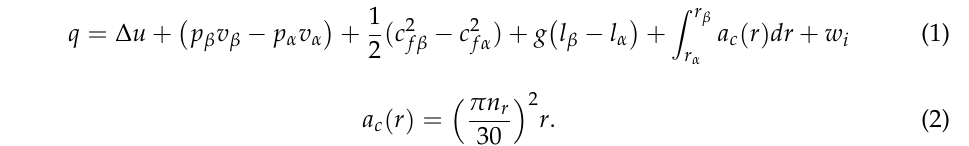
Figure 2. The schematic of rotor evaporative cooling system. 1-condenser outlet; 2-liquid level; 3-pole inlet; 4-evaporation point (the coolant be-